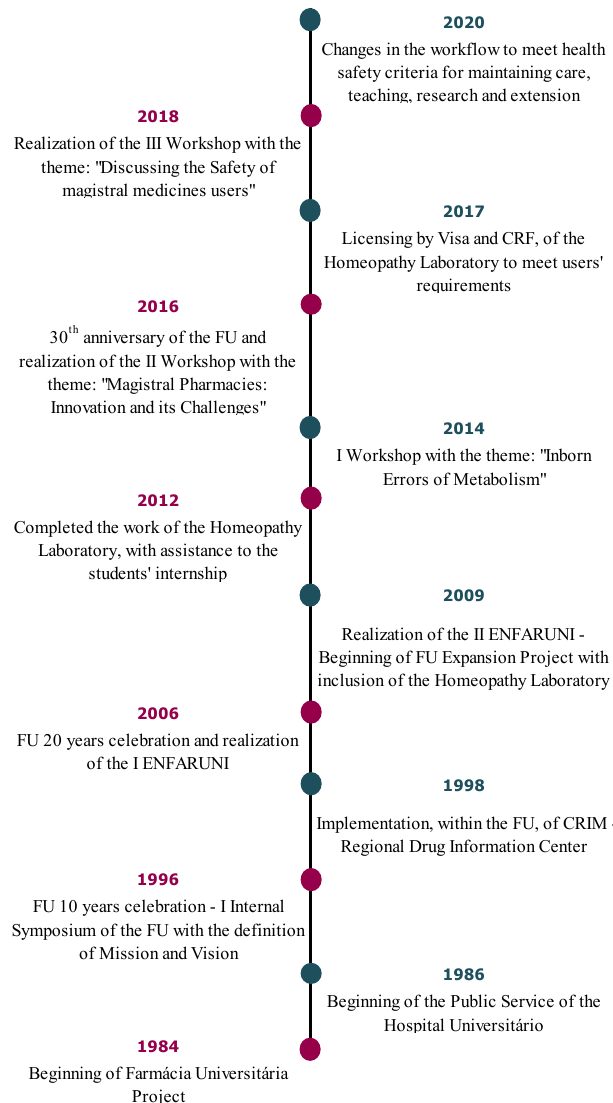
FIGURE 1 - Chronological order of the teaching, research and extension at